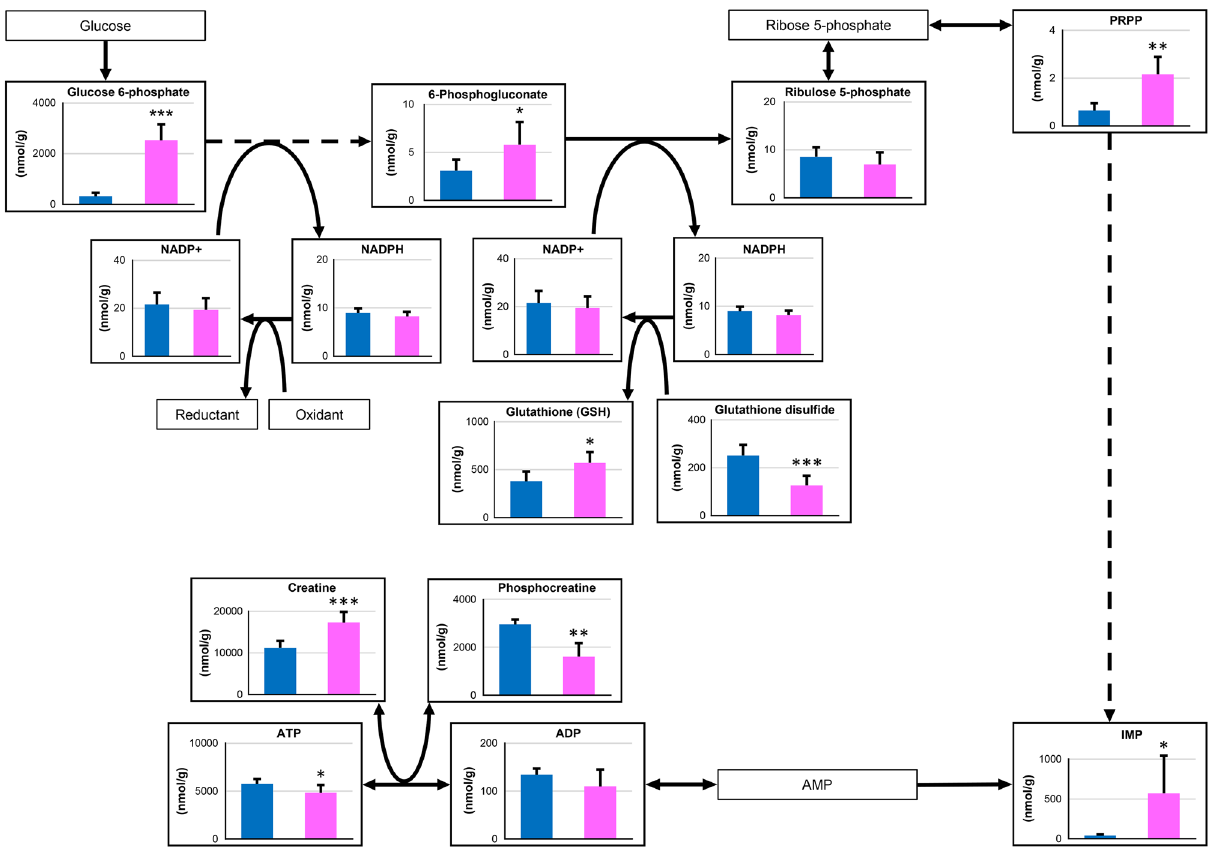
Figure 4. Observed changes in metabolites mapped onto the pathways associated with pentose phosphate pathway and high-energy phosphate compounds. Asterisks show significant differences between before and after exercise by Welch’s t-test (* < 0.05, ** < 0.01, *** <